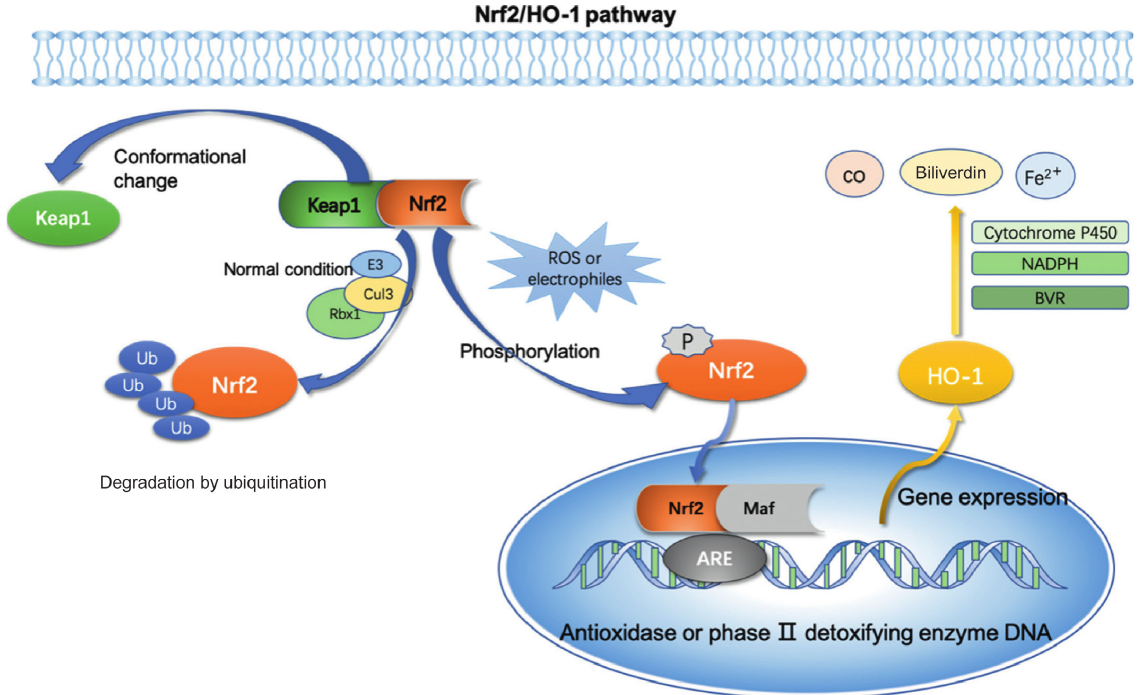
Figure 1: Specific signal transduction of the Nrf2/HO-1 signaling